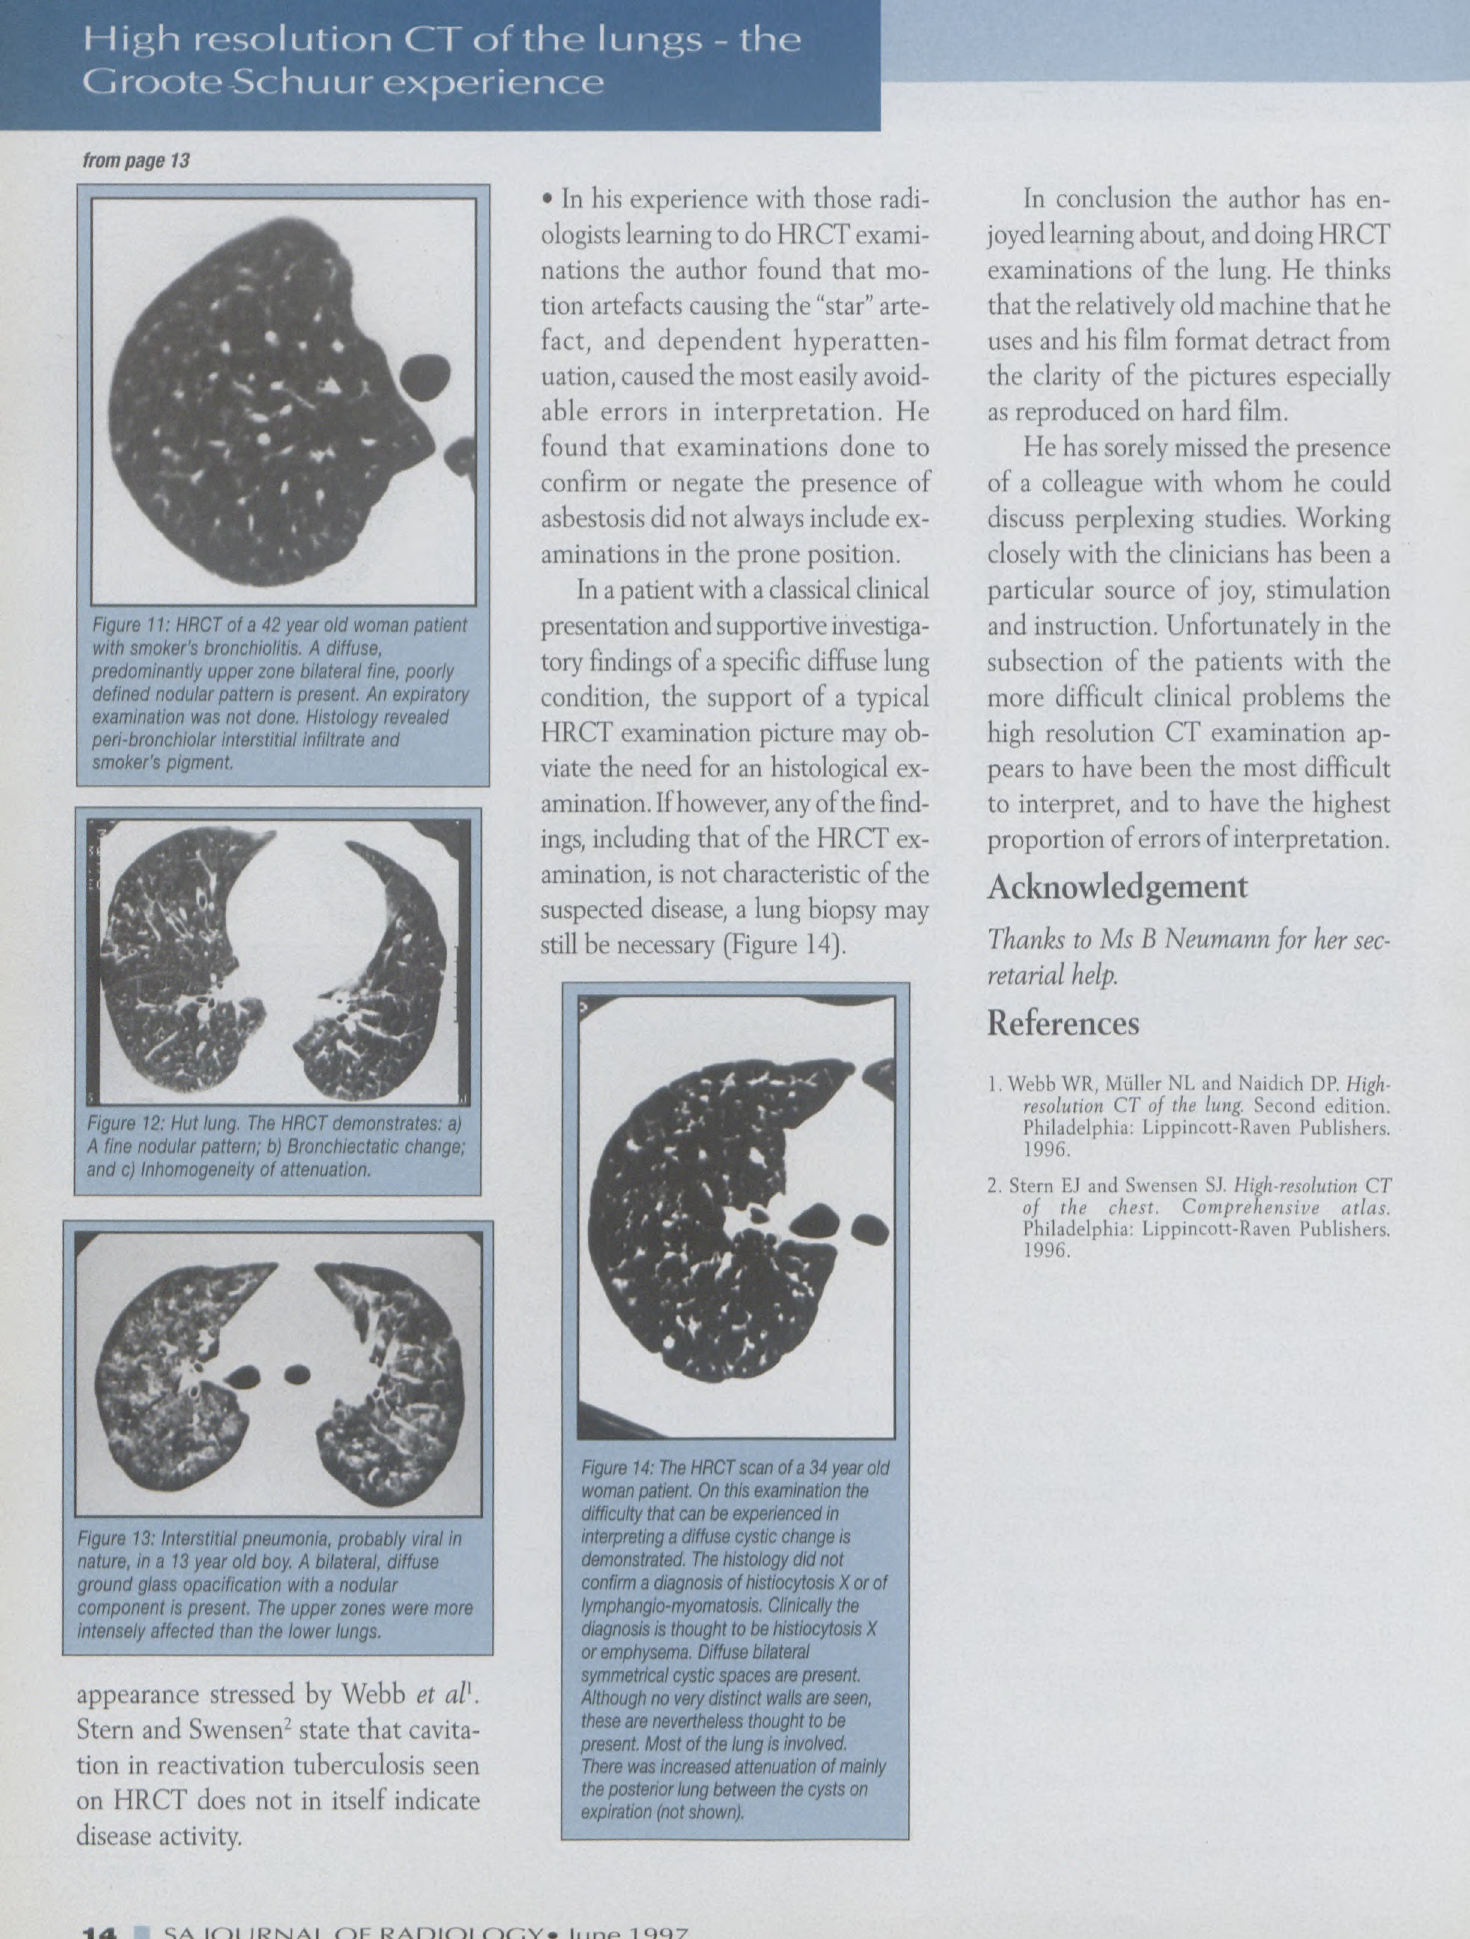
Figure 13: Interstit/al pneumonia, probably viral in nature, in a 13 year old boy. A bilateral, diffuse ground glass opacification with a nodular component is present. The upper zones were more intensely affected than the lower lungs.